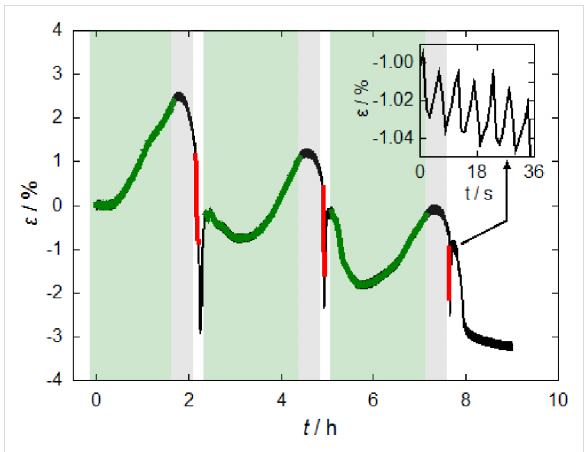
Figure 7: Strain ε as a function of the time t for constant-current/con- stant-potential (2 mA – green, − 1 V – grey bars) loading of hydrogen in nanoporous palladium followed by galvanostatic unloading at 32 mA, 64 mA and 128 mA (red) in 1 M KOH solution. The inset shows